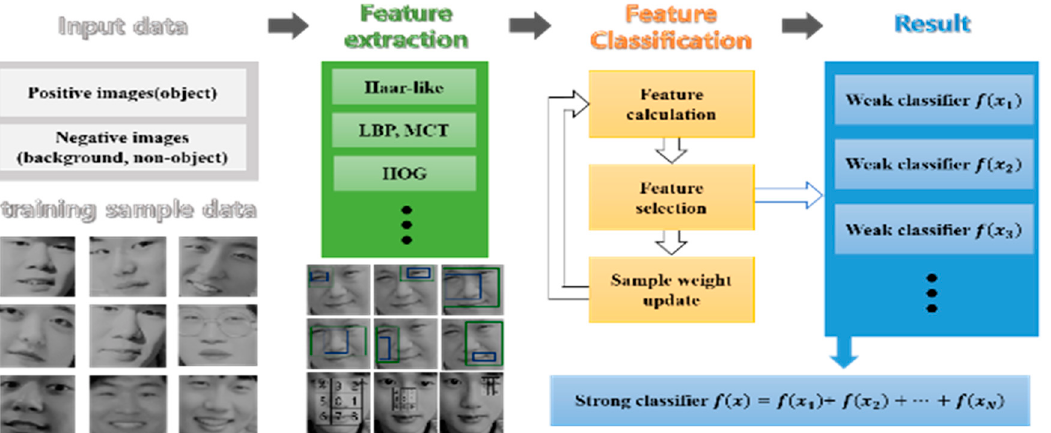
Figure 4. System-wide process for interview management.